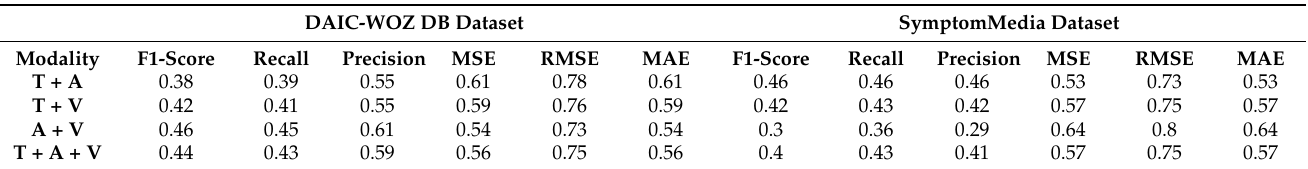
Table 6. The performance and error metrics for the SVM + RF with RF late fusion (T + A: text and audio; T + V: text and video; A + V: audio and video; T + A + V: text, audio, and video). DAIC-WOZ DB Dataset